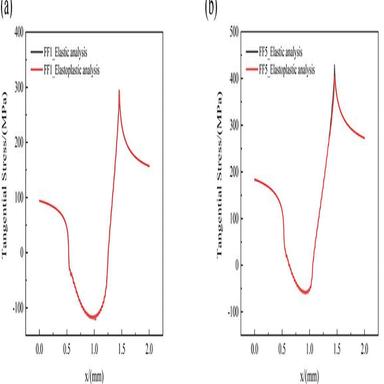
Comparison of tangential stress in FF tests between the elastic analysis and the elastoplastic analysis: (a) Test No. 1 and (b) Test No. 5.